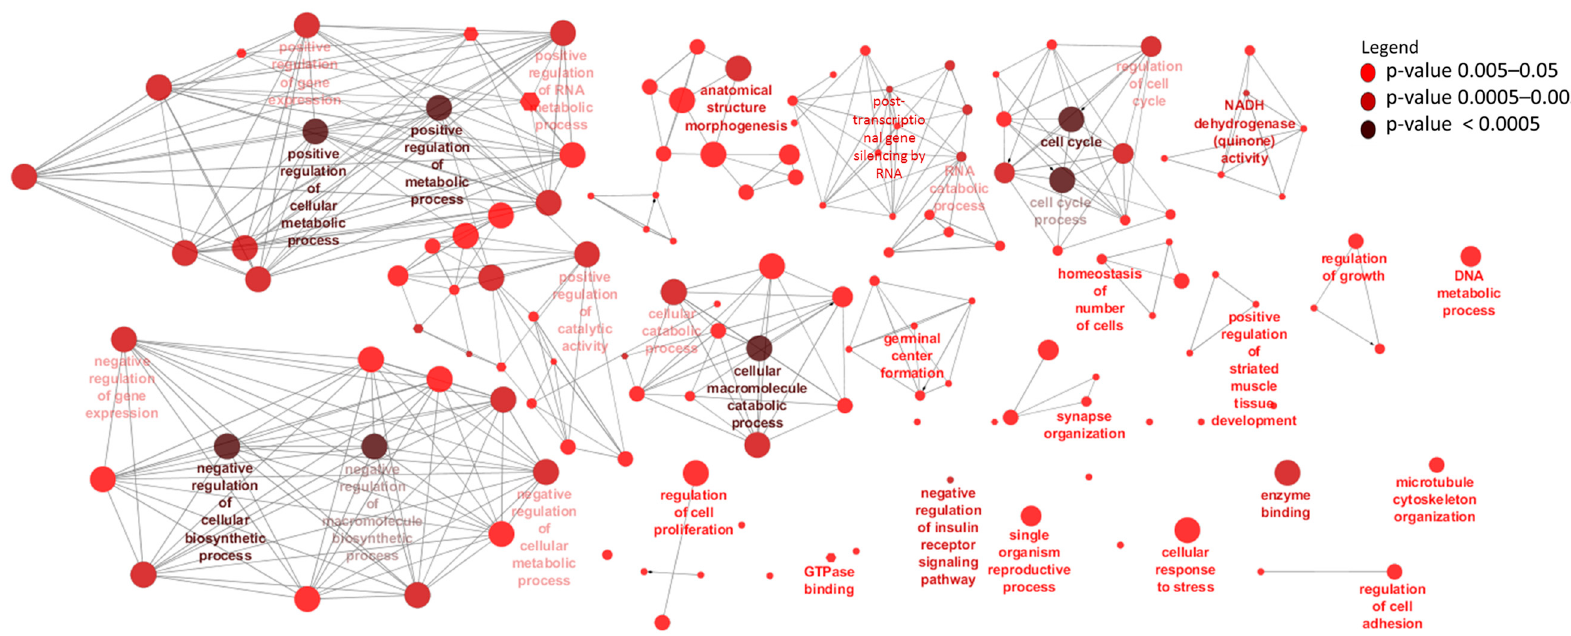
Figure 3. Gene ontology terms enriched for rumen long non-coding RNA (lncRNA) cis target genes. Only the relevant or highly significantly enriched terms are shown. See Supplementary Table S9a for detailed results. GTPase: Single GTPase (guanosine triphosphate); NADH: Nicotinamide adenine dinucleotide reduced form.